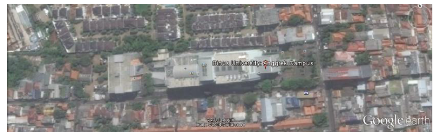
Figure 1: The location of Bina Nusantara University